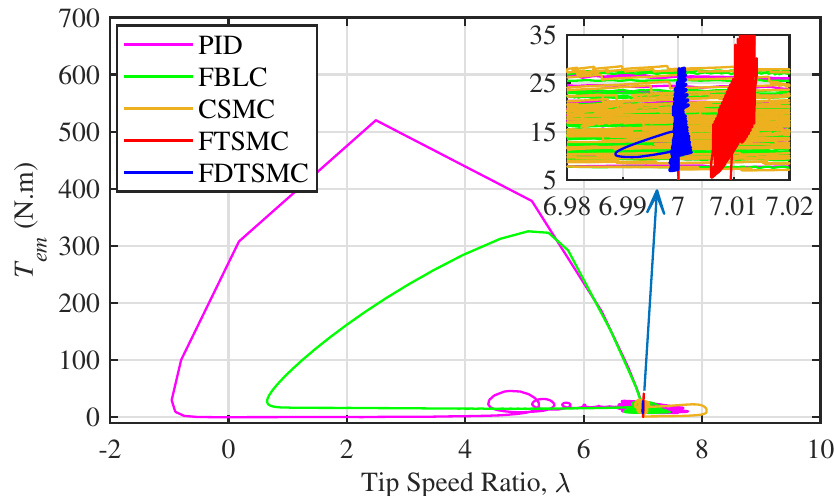
Figure 13. Electromagnetic torque versus the tip speed ratio performance.